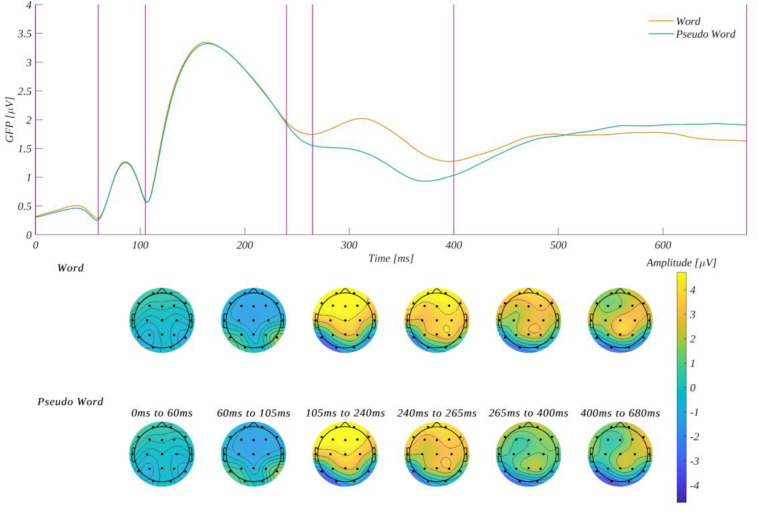
Global field power for words and pseudowords stimuli (upper part), and the topographies of average amplitude in a given time-window (bottom part). The vertical lines in the upper plot indicate time-window boundaries.